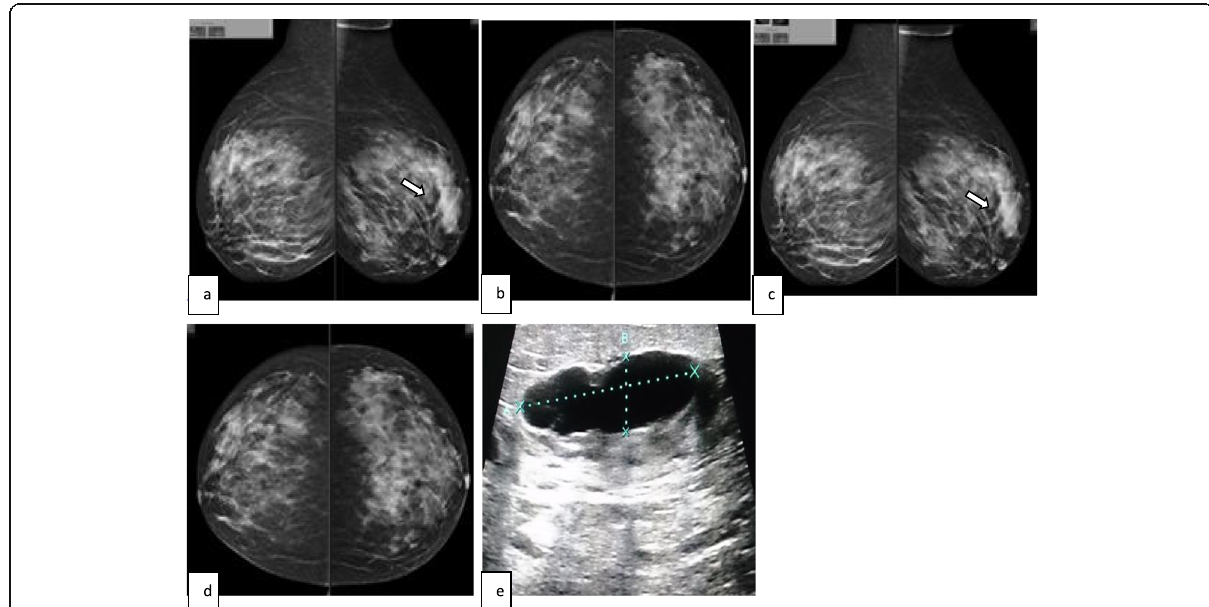
Fig. 10 (Case no. 3) A 48-year-old patient came for regular screening. Mammography revealed breast density: ACR C. and left upper outer quadrant focal asymmetry (BIRADS3) ( a , b ). 3D tomosynthesis revealed: left upper outer quadrant focal asymmetry (BIRADS 3), tomosynthesis did not add to the mammography ( c , d ). Breast ultrasound revealed: multiple well-defined variable-sized thin wall anechoic cysts with posterior enhancement, the largest measuring (3.5 × 1 cm) (BIRADS 2) ( e ). Final diagnosis: fibrocystic changes